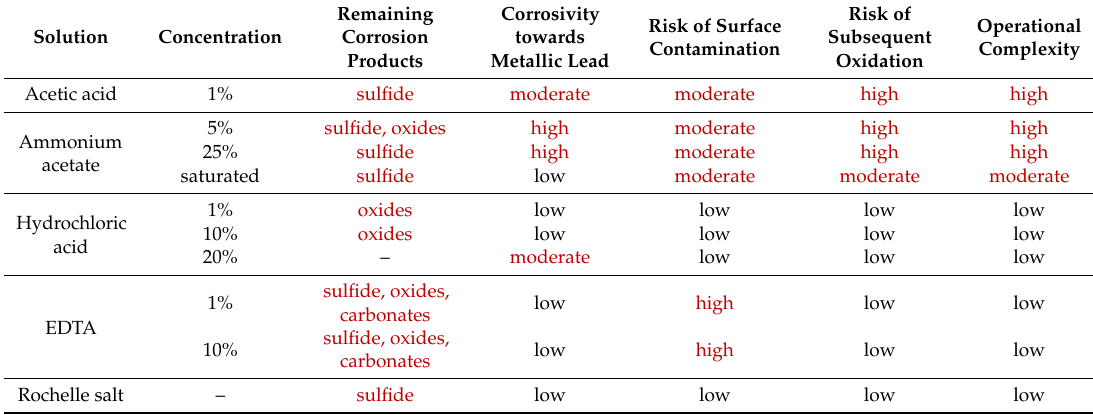
Risk of Corrosivity Remaining Operational Risk of Surface Subsequent Corrosion towards Complexity Contamination Oxidation Metallic Lead Products